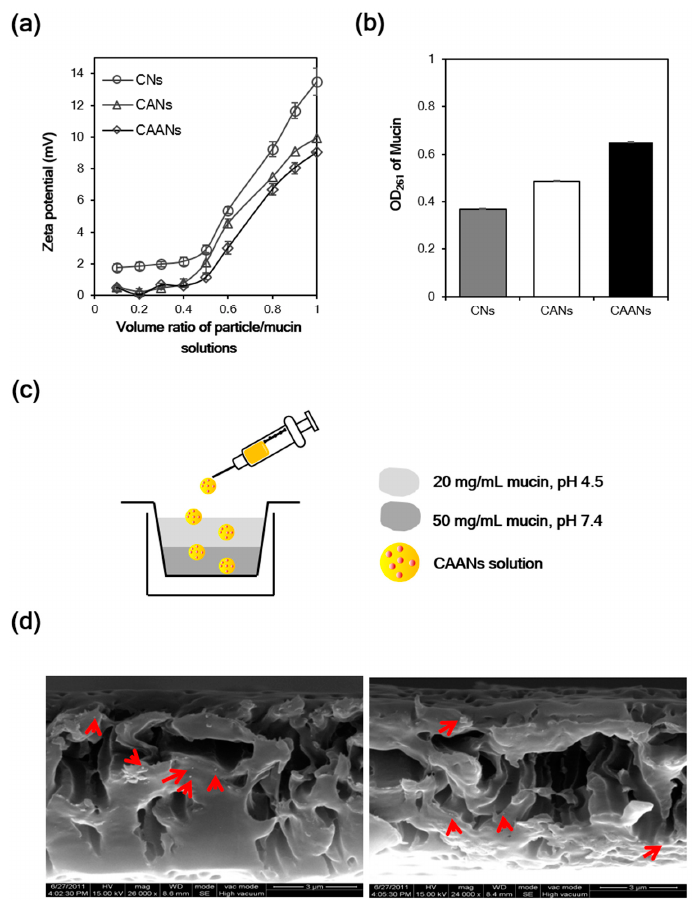
Figure 3. ( a ) Surface charge change of mucin particles in the CNs, CANs and CAANs solutions. ( b ) The OD value of unbound mucin at 261 nm after the contact with CNs, CANs and CAANs solutions. ( c ) Schematic illustration of the model used to mimic the mucus layer for the mucopenetration test. ( d ) Scanning electron microscope images of CAANs (red arrow) distributed in the mucin layer.